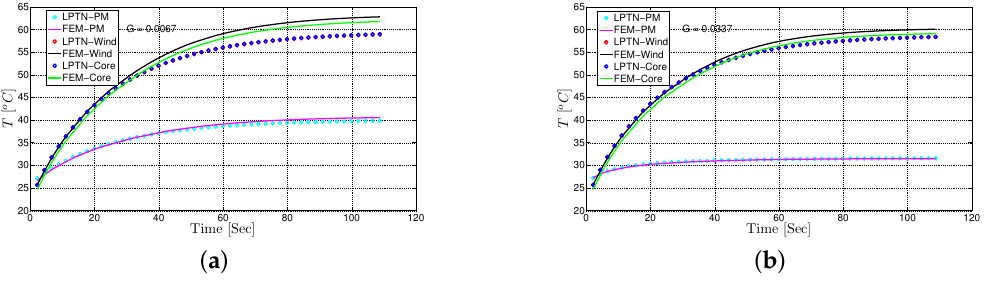
Figure 14. Machine temperature at ( a ) G = 0.0067; ( b ) G = 0.0337.